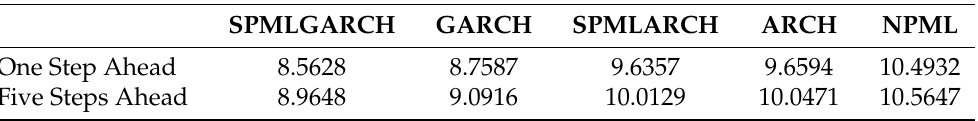
Table 3. The table reports RMSFE’s for h = 1 and h = 5 steps ahead forecasts and for the following estimators: SPMLGARCH, SPMLARCH, GARCH, ARCH, and